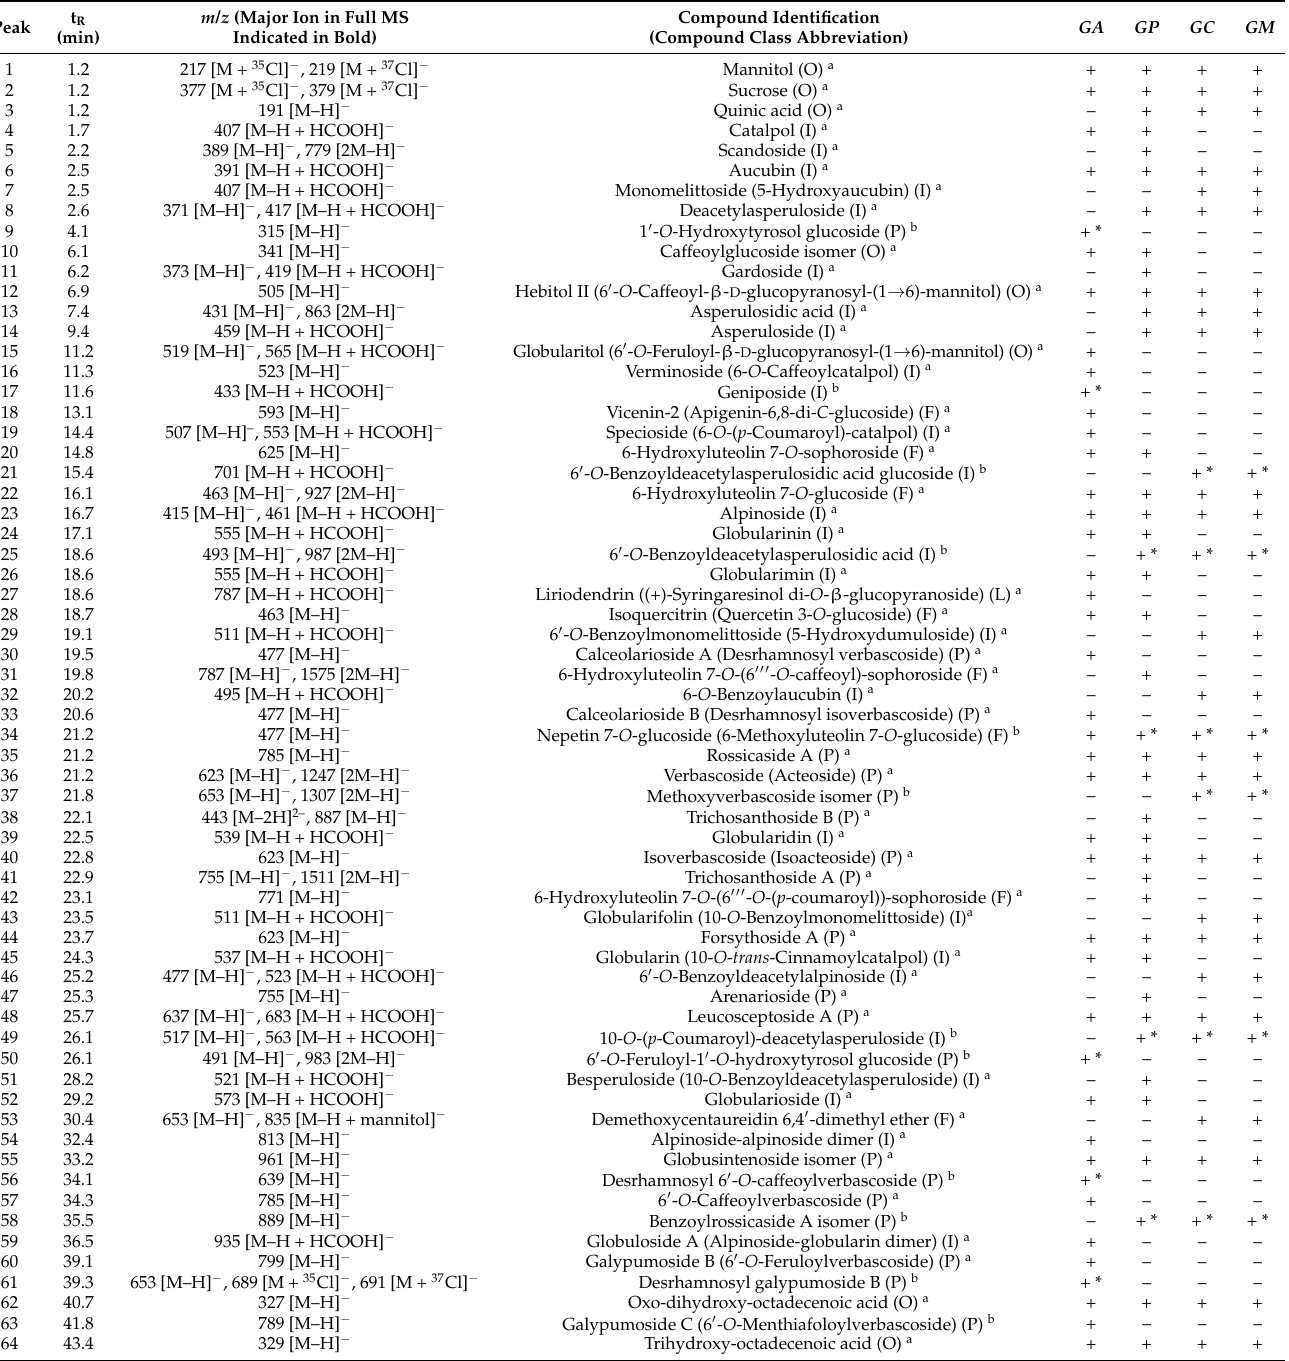
Table 3. LC-MS profile of methanolic leaf extracts from G. alypum ( GA ), G. punctata ( GP ), G. cordifolia ( GC ) and G. meridionalis ( GM ) obtained by ultrasound-assisted